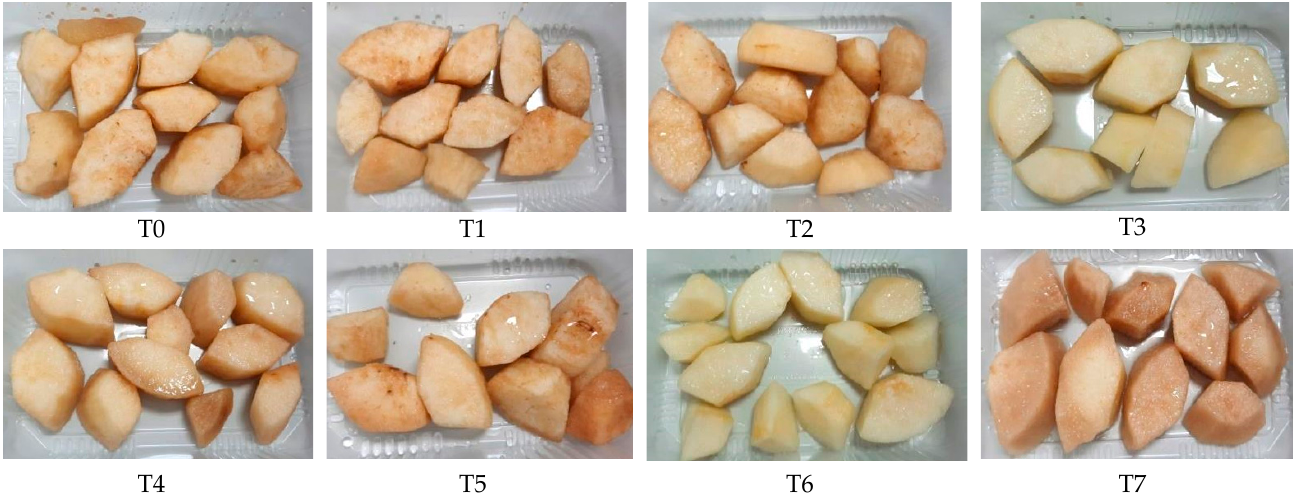
Figure 3. Appearance of fresh-cut pears after 12 days of storage at 8 ± 1 °C. T0—Control;